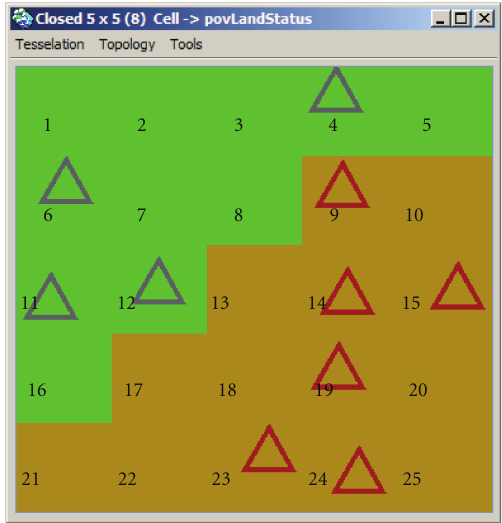
Figure 2: Game spatial setting with community land (bottom) and MHP forest concession